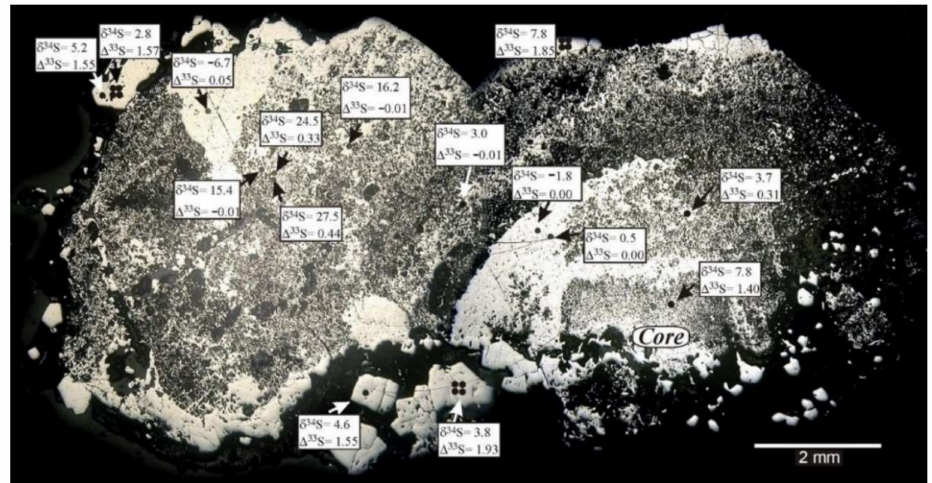
Figure A4. Reflected light microscopy image of the concentrically laminated pyrite grains surrounded by euhedral pyrite crystals. Note that the sample is the same as in Figure A3A. Also shown are ablation pits for in situ sulfur isotope analysis of δ 34 S and ∆ 33 S.